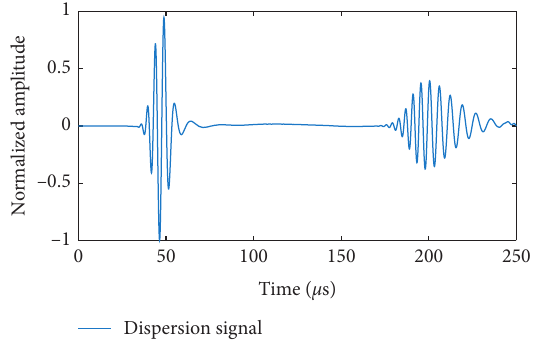
Figure 7: Raw signal with direct and reflected A